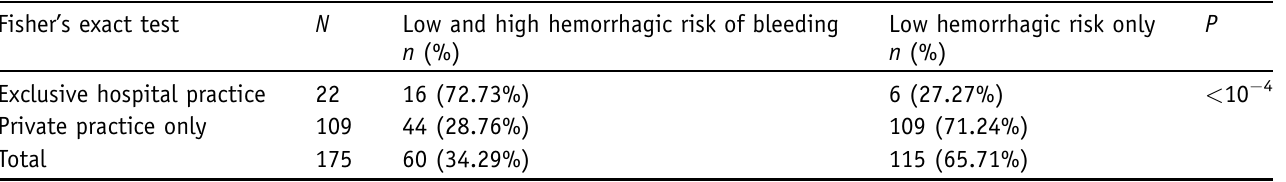
Table I. Management of the surgical procedures with high hemorrhagic risk according to the practice pro fi le of the respondents.